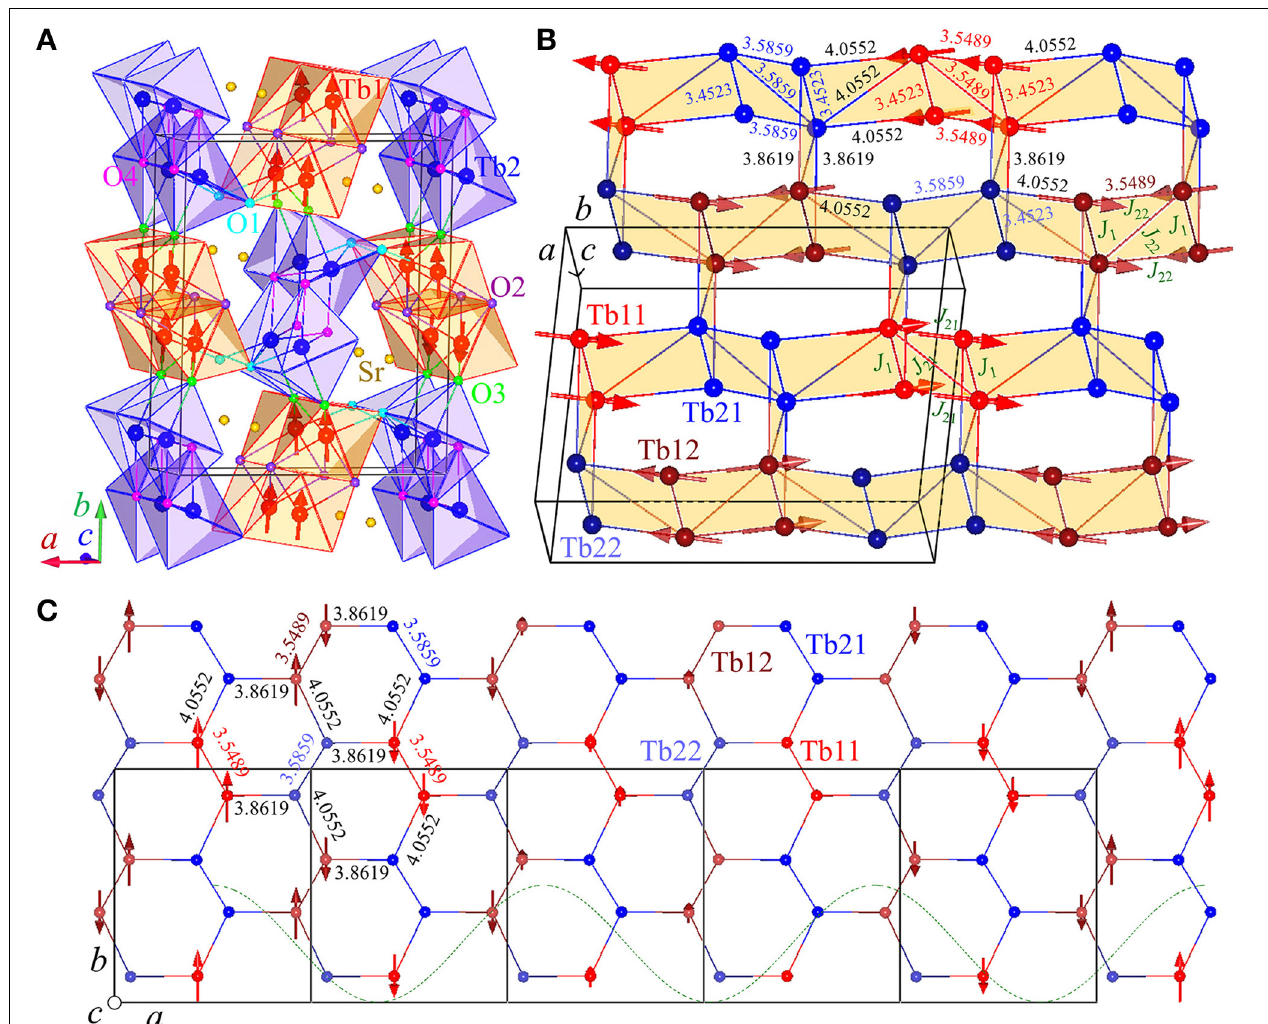
incommensurable spin modulation along the a axis. In (A–C) , the arrows drawn through the Tb1 ions represent the Tb1 partially-ordered moments, and the connected lines represent the crystallographic unit cell(s). To clearly show the magnetic frustration, Tb1 and Tb2 sites in (A) are transferred into Tb11 and Tb12 as well as Tb21 and Tb22 sites, respectively, as shown in (B,C) by the irreducible representation analysis to the P -1 symmetry